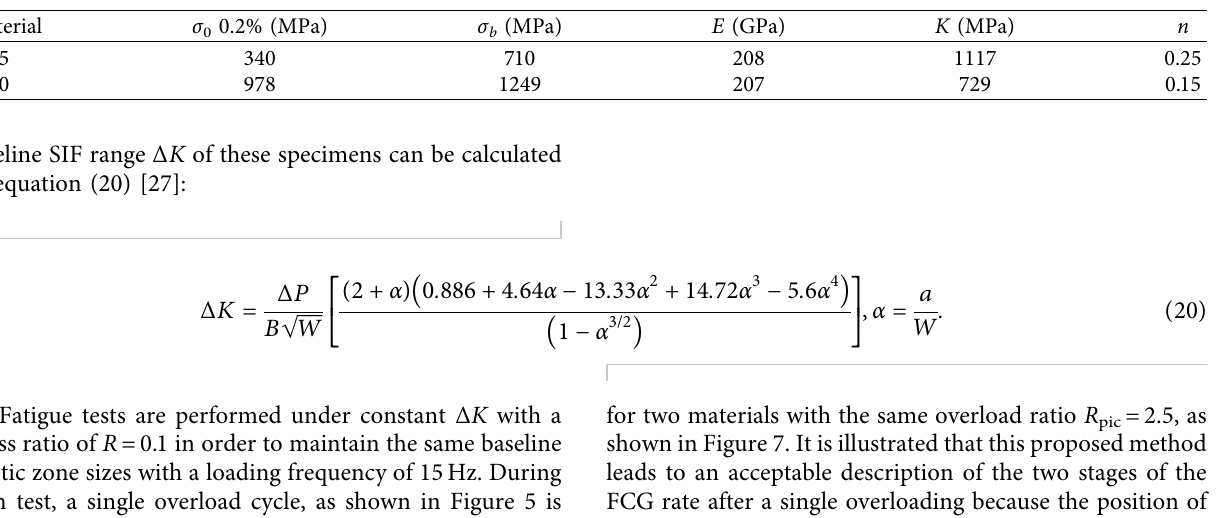
Figure 4: CT specimen mounted in a fatigue machine. Table 1: Mechanical properties of tested